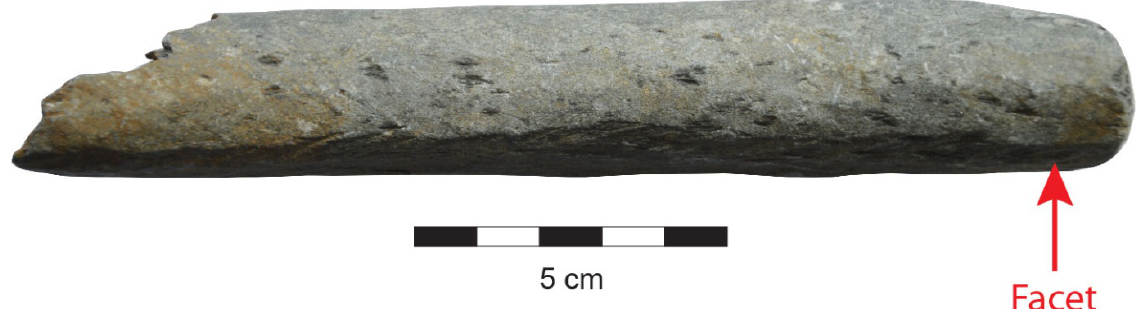
Figure 14: Polished whetstones with facets, Le